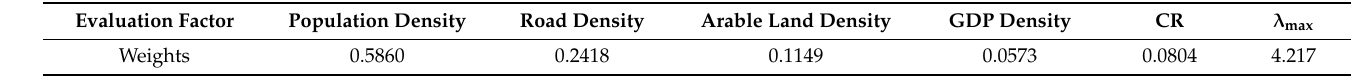
Table 7. Subjective weights and maximum eigenvalues of vulnerability assessment factors.